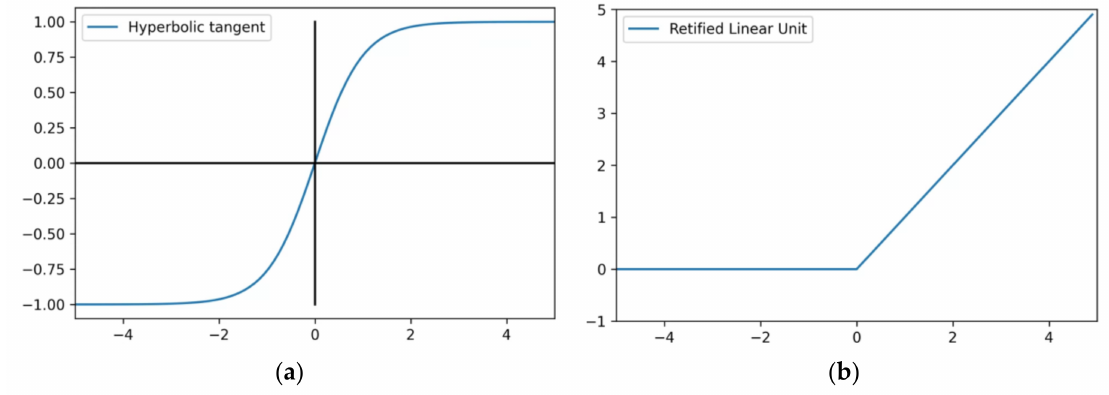
Figure 6. Activation functions: ( a ) hyperbolic tangent; ( b ) rectified linear unit. The epoch represents the number of learning iterations, and as the epoch increases, the number of iterations of learning increases. Figure 7 shows the learning loss when the epoch is increased from 0 to 100.